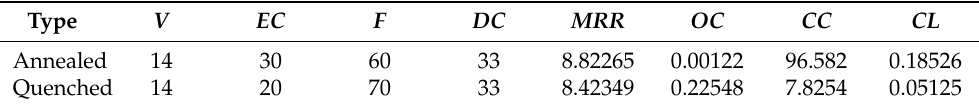
Table 13. Confirmation test for annealed and quenched process.